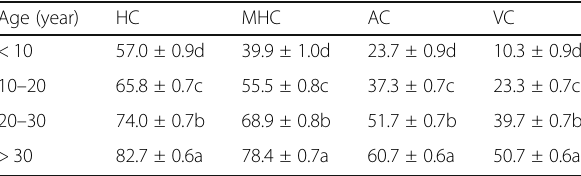
Table 6 Root colonization (%) of AMF structures at four age groups of